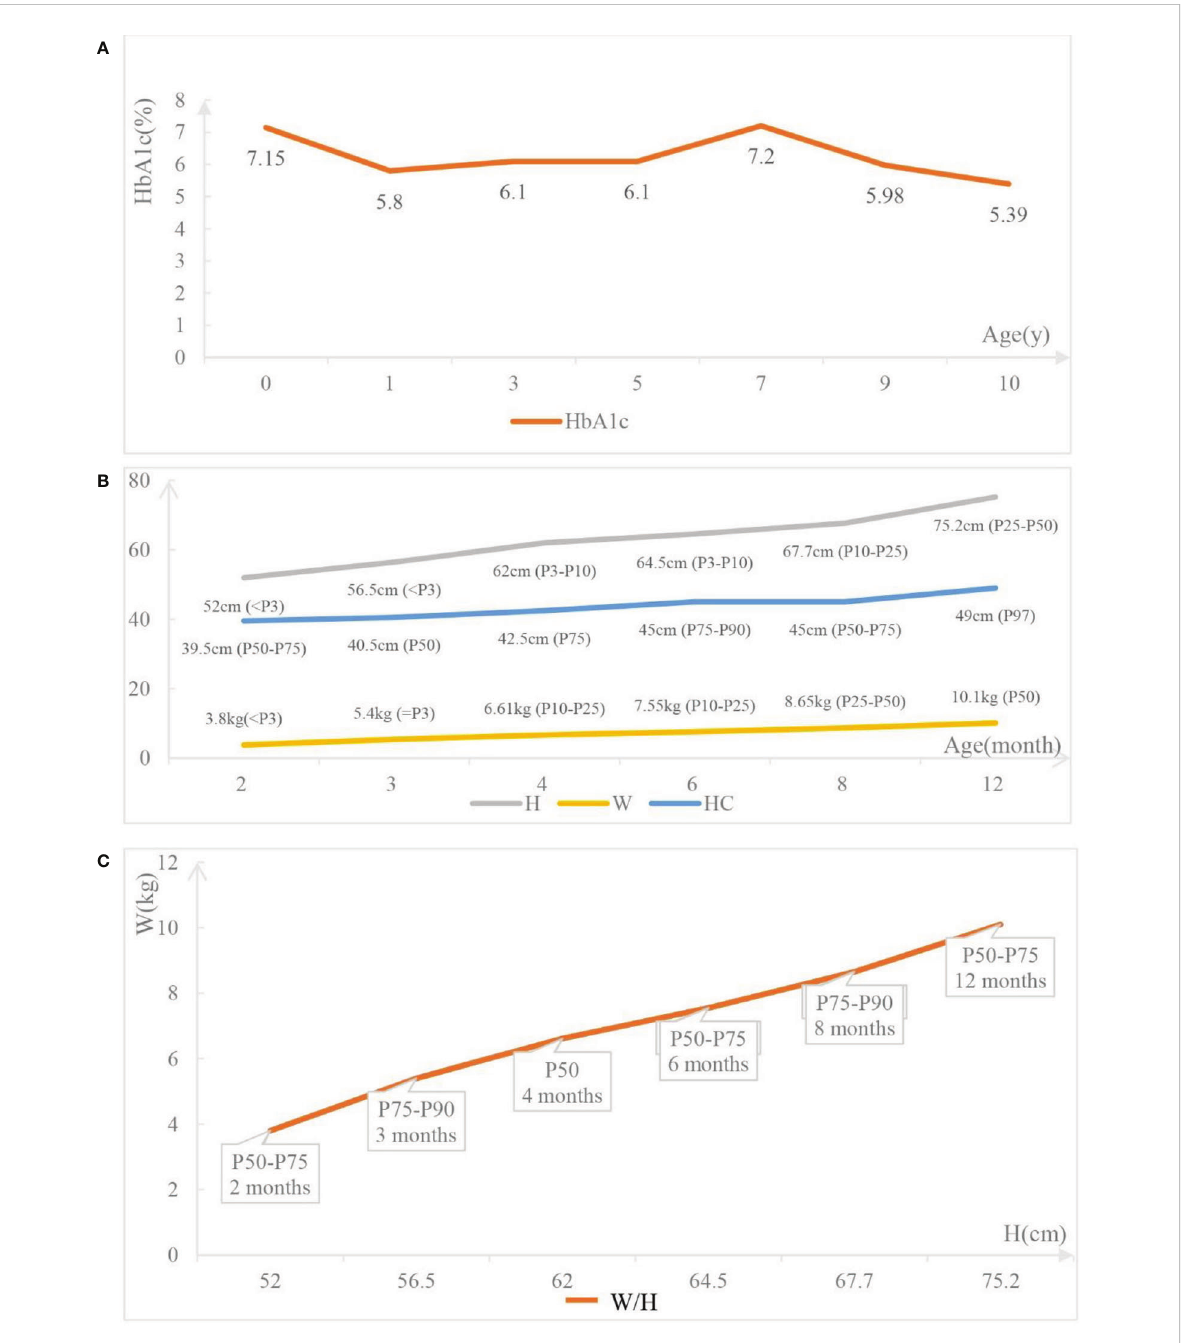
FIGURE 2 The follow-up data of the patient. (A) The hemoglobin Alc (HbA1c) levels of the patient at different time point. (B) Growth and development of the patient. H: the height of the patient; W: the weight of the patient; HC: the head circumference of the patient. (C) W/H: the weight-for- height of the